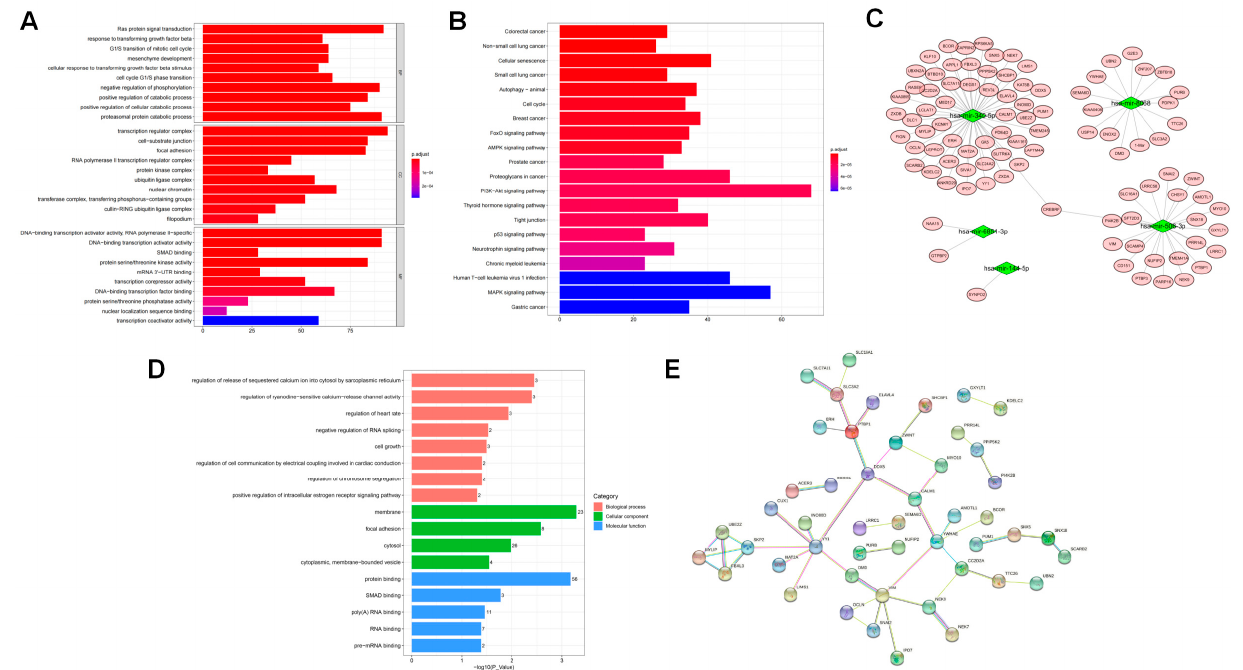
Figure 5. Bioinformatics analysis based on DEmiRNA target genes. ( A ) The top 10 significant terms in GO analysis (BP/CC/MF). ( B ) The top 20 significant terms in KEGG enrichment analysis. ( C ) The regulatory network of candidate key miRNA target genes. ( D ) GO analysis of targeted genes of candidate key miRNAs. ( E ) PPI network of candidate key miRNA target genes. DEmiR- NAs, differentially expressed miRNAs; GO, Gene Ontology; BP, biological process; CC, cellular component; MF, molecular function; KEGG, Kyoto Encyclopedia of Genes and Genomes; and PPI, protein–protein interaction.